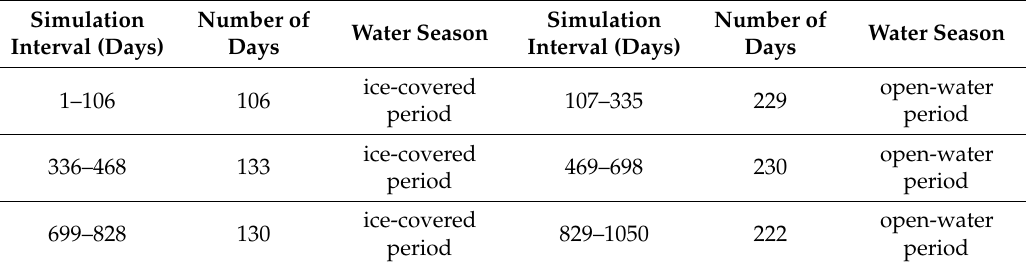
Table 1. Simulation intervals for hydrodynamic water quality model of the Mudan River trunk